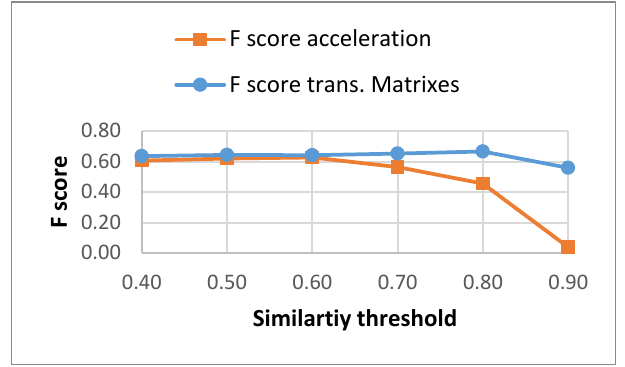
Figure 4. F -score for different similarity threshold for both methods.